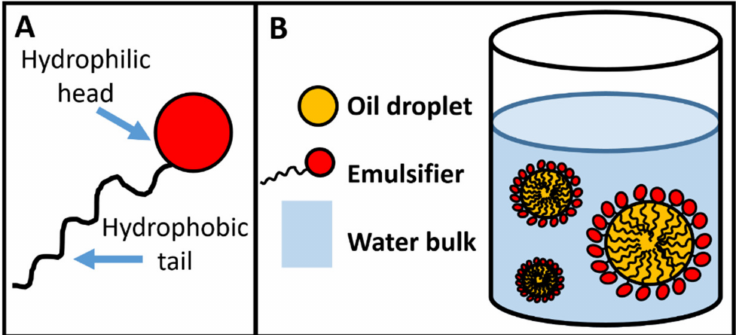
Figure 2. Schematic structure of surfactants ( A ) and oil-in-water emulsion-based system ( B